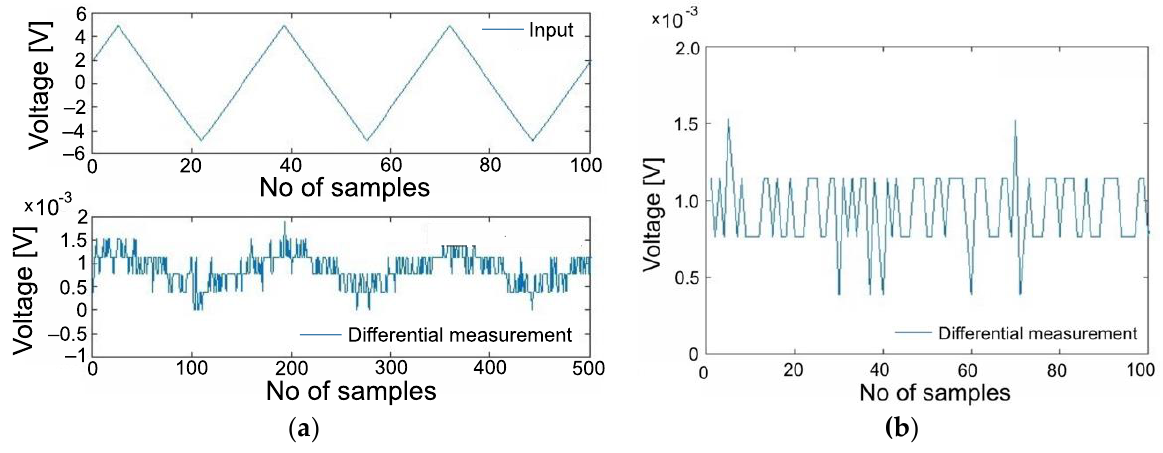
Figure 11. CMRR measurement ( a ); noise at the measurement input ( b ).